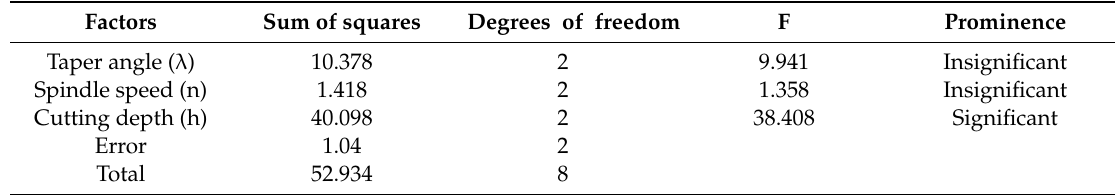
Table 7. Analysis result of surface roughness (Ra).